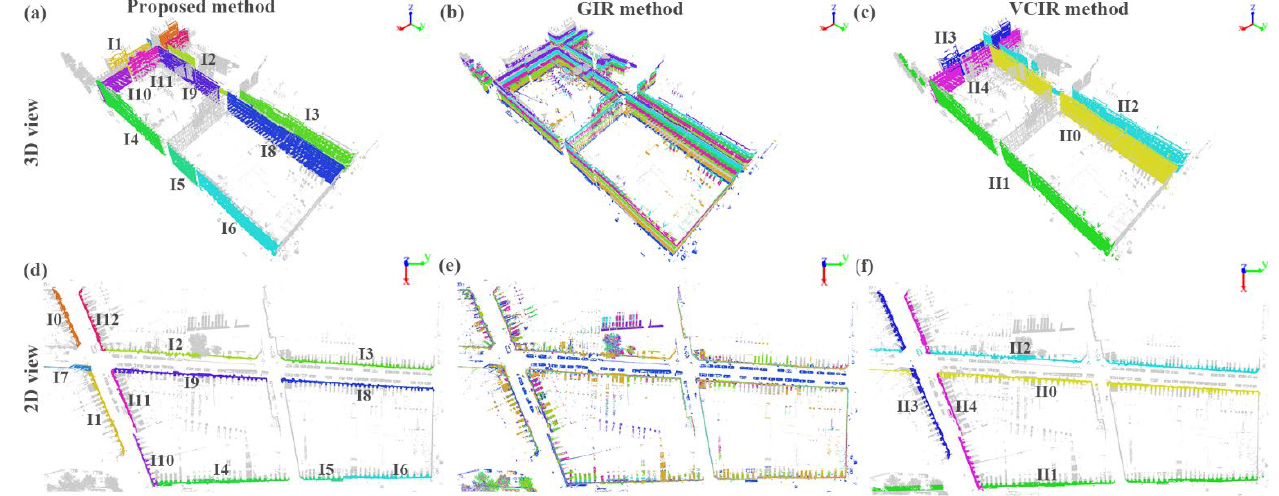
Figure 9. Facade extractions from the IQmulus & TerraMobilita Contest dataset: ( a – c ) the results in 3D view extracted by the proposed method, GIR method, and VCIR method, respectively; and ( d – f ) the results in 2D view extracted by the proposed method, GIR method, and VCIR method, respec- tively. Different colors were used for different facades and gray for nonfacade point clouds. Roman numeral I was used to number the facades extracted by the proposed method and Roman numeral II was used for the VCIR method.